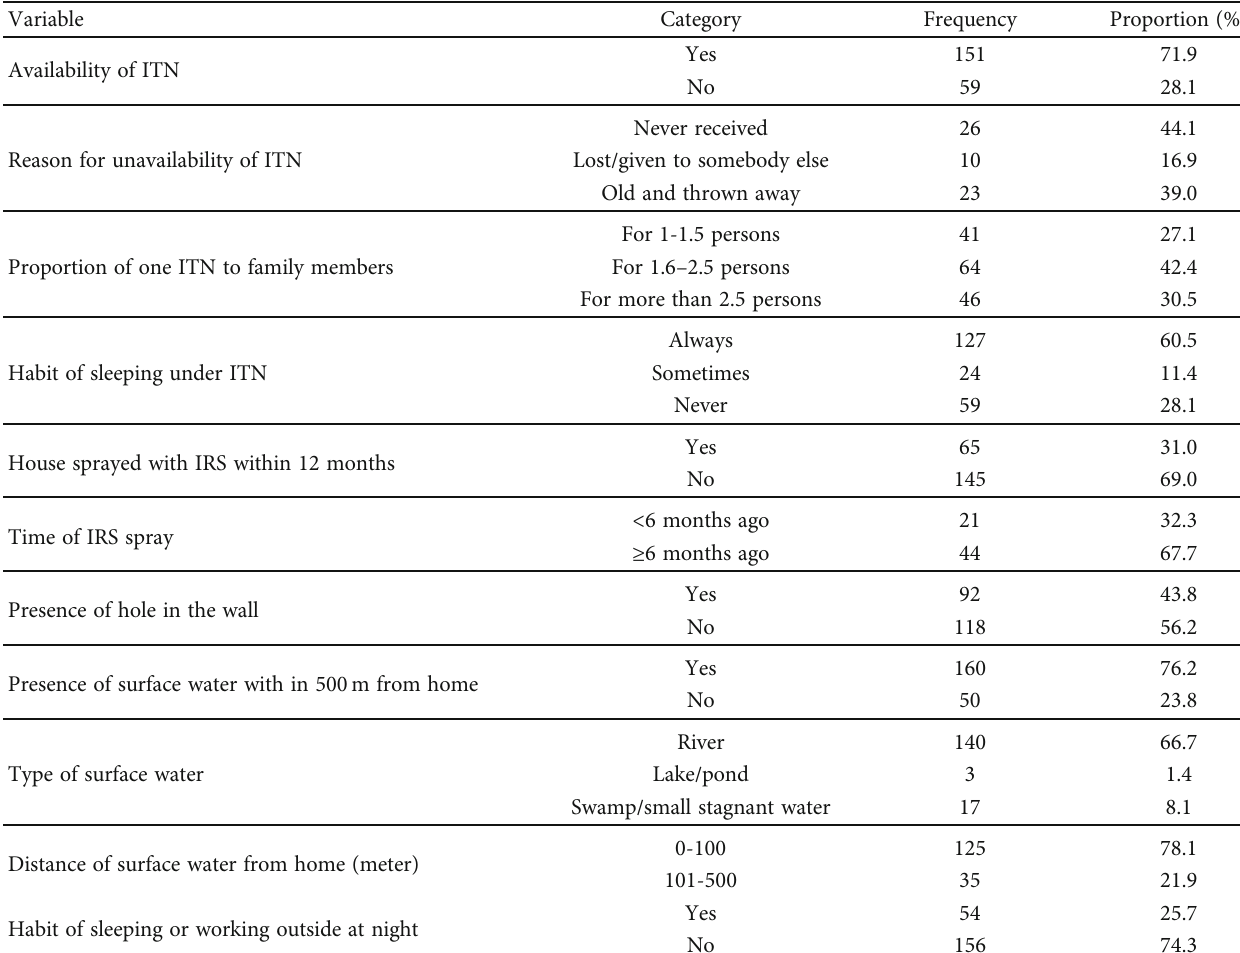
Table 3: Malaria control activities and conditions among febrile patients attending Hamusit Health Center, Northwest Ethiopia, 2020. Variable